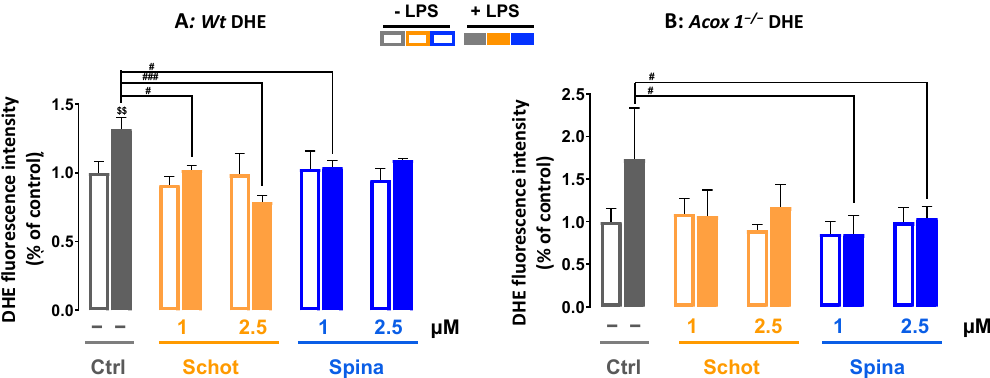
Figure 3. Effect of Schot and Spina on ROS production induced by LPS in the Wt ( A ) and Acox1 − / − ( B ) BV-2 microglial cells assessed by the DHE (5 µ M) dye test. Cells were incubated for 7 h with Schot or Spina (1 or 2.5 µ M) in the presence or absence of LPS (1 µ g/mL). All values are presented as means ± SD of two independent experiments performed in triplicate, with the statistical significance of the increase in mean signal indicated as ### p ≤ 0.01, # p ≤ 0.05 compared to LPS and $$ p ≤ 0.01 compared to the different treatments with or without LPS administration. Statistical significance was determined using two-way ANOVA followed by Tukey’s test for multiple comparisons.